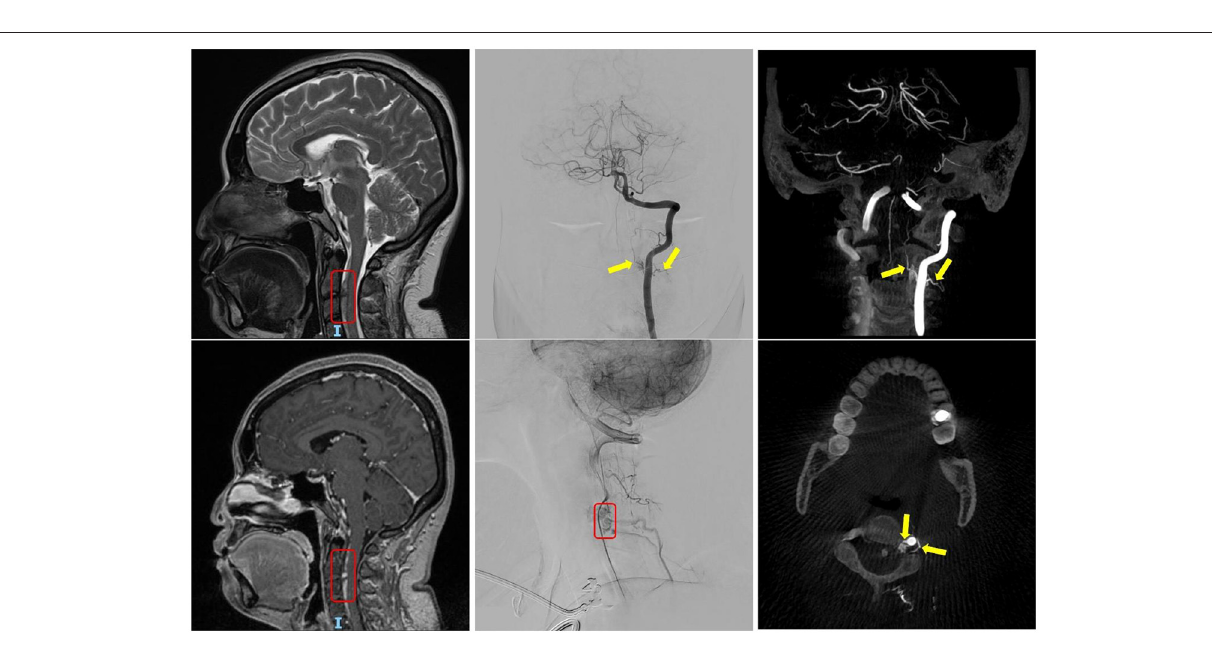
FIGURE 2 | The left panels show the finding of the C2–3 dural arteriovenous fistula (AVF) in routine MRI head, highlighted within the red box. The middle and right panels show the digital subtraction angiography (DSA) cervical spine and the angio-CT of L-VA. The yellow arrows indicate the two supplying arteries; and the red boxes indicate tortuous venous drainage of the